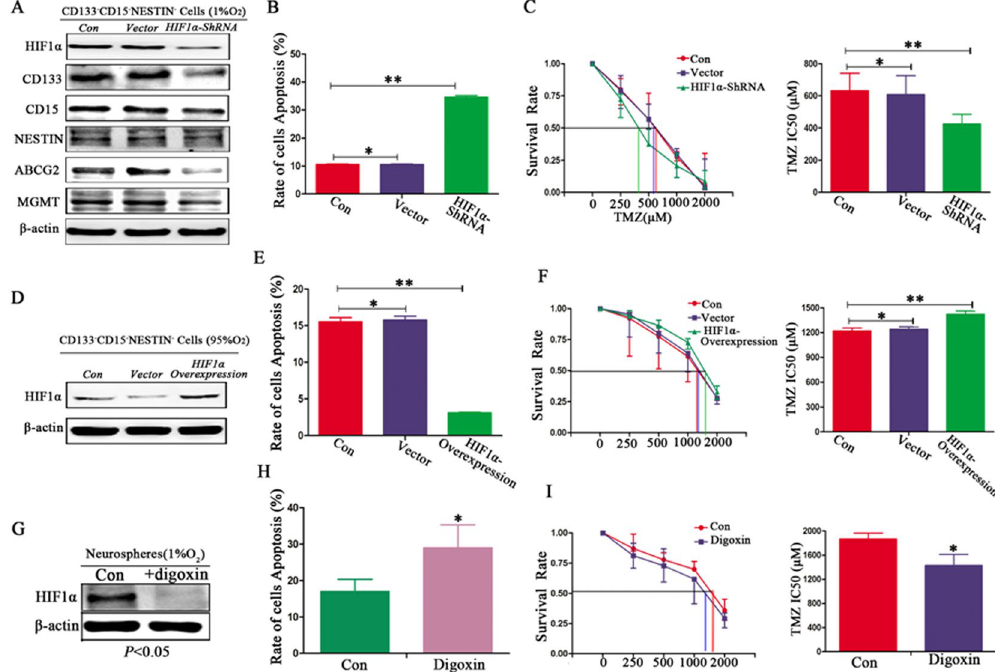
Figure 7. Influences of HIF1 α on protein expression and cell apoptosis. ( A ) After interfering with HIF1 α expression using ShRNA, HIF1 α levels were substantially lower, and the levels of CD133, CD15, NESTIN, ABCG2 and MGMT for HIF1 α -silenced U87 CD133 − /CD15 − /NESTIN − cells were significantly decreased compared with the control and vector-U87 CD133 − /CD15 − /NESTIN − cells under 1%O 2 conditions. ( B ) HIF1 α -silenced U87 CD133 − /CD15 − /NESTIN − cells presented an approximately 3.6-fold higher apoptosis rate than the control and U87 vector cells in the hypoxic environment after TMZ (100 μ M) treatments ( * P > 0.05; ** P < 0.05, One-way ANOVA). ( C ) HIF1 α -silenced U87 CD133 − /CD15 − /NESTIN − cells exhibited a decreased survival rate with a lower IC50 in the hypoxic environment ( * P > 0.05; ** P < 0.05, One-way ANOVA). ( D ) HIF1 α was over-expressed for U87 CD133 − /CD15 − /NESTIN − cells in a 95%O 2 environment, and western blotting indicated that HIF1 α expression was significantly increased. ( E ) Decreased apoptosis was noted for HIF1 α -over-expressed U87 CD133 − /CD15 − /NESTIN − cells compared with control and vector cells in the hyperoxic environment after TMZ (100 μ M) treatments ( * P > 0.05; ** P < 0.05, One-way ANOVA). ( F ) HIF1 α - over-expressed U87 CD133 − /CD15 − /NESTIN − cells exhibited an increased survival rate with a higher IC50 in the hyperoxic environment ( * P > 0.05; ** P < 0.05, One-way ANOVA). ( G ) Western blot indicated there was reduced HIF1 α expression for U87 CD133 + /CD15 + /NESTIN + neurospheres after digoxin (100 μ M) treatment. ( H ) Cell apoptosis occurred at a higher rate in U87 CD133 + /CD15 + /NESTIN + neurospheres treated with digoxin after TMZ (100 μ M) treatment in the hypoxic environment than in cells without digoxin ( * P < 0.05, Paired-samples T Test). ( I ) Lower survival rates and 2-fold decrease of IC50 for U87 CD133 + /CD15 + /NESTIN + neurospheres treated with digoxin after TMZ treatments were detected in the hypoxic environment ( * P < 0.05, Paired-samples T